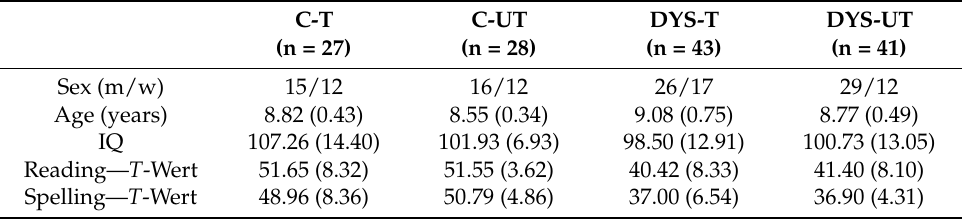
Table 1. Sex distribution and means (standard deviations) of age, IQ, spelling t-scores and reading t-scores by